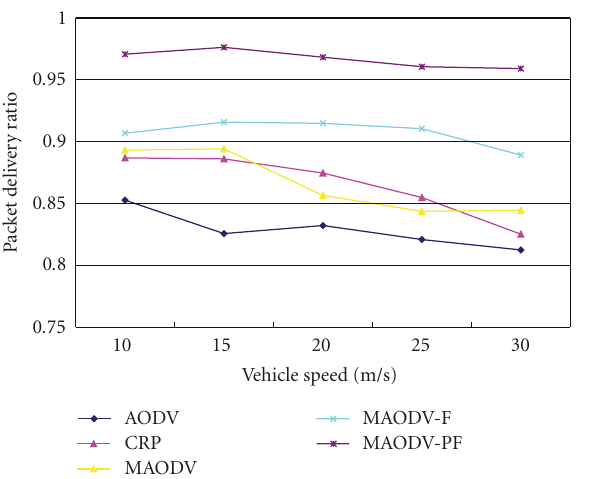
Figure 9: Control overhead for CRP, AODV, MAODV, MAODV-F, and MAODV-PF under di ff erent moving